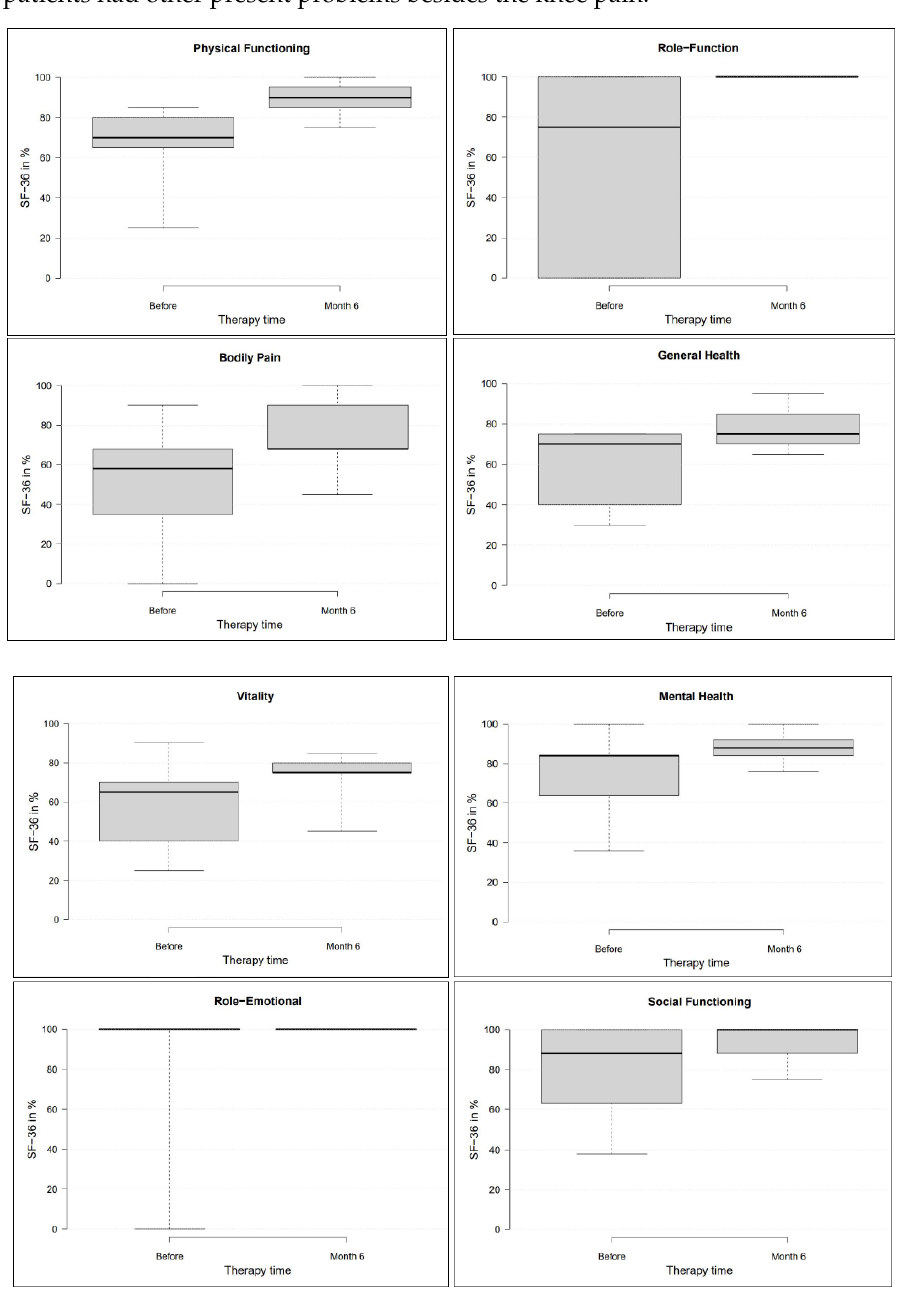
Figure 5. The eight domains of the SF-36 questionnaire before therapy and after six months. showed significant improvements ( p < 0.05). The two domains role-emotional and